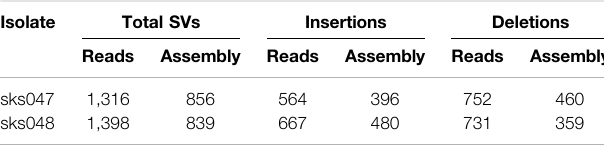
TABLE 4 | Summary of reads-based and assembly-based structural variants.